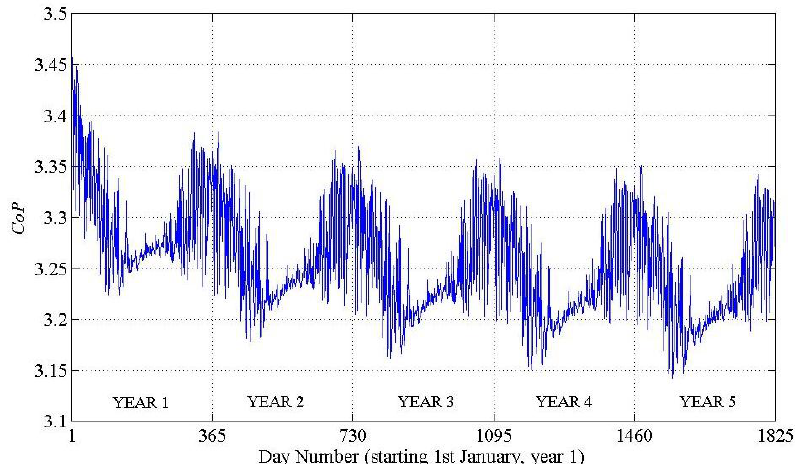
Figure 7. Mean daily heat pump CoP (mid-terrace house).